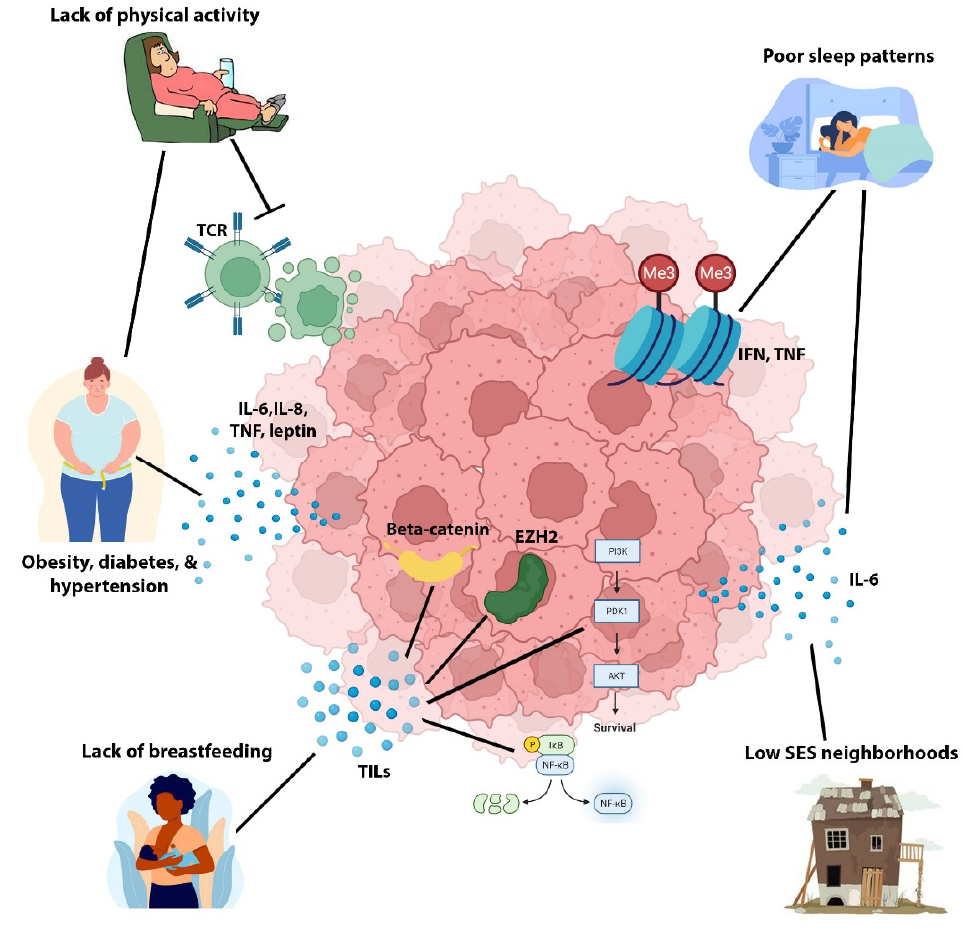
Figure 2. Potential influence of non-genetic risk factors on aggressive QNBC biology. Non-genetic risk factors such as co-morbid conditions (obesity, diabetes mellitus, and hypertension) poor sleep patterns, lack of physical activity, stress, low socioeconomic status (SES), and lack of breast feeding has been linked to aggressive basal-like TNBC biology, which reflects QNBC, via upregulating tu- mor-promoting inflammation and downregulating antitumor immunity. Abbreviations: IFN, inter- feron; TNF, tumor necrosis factor; IL-6, interleukin-6; IL-8, interleukin-8; TILs, tumor infiltrating lymphocytes; TCR, T cell receptor.